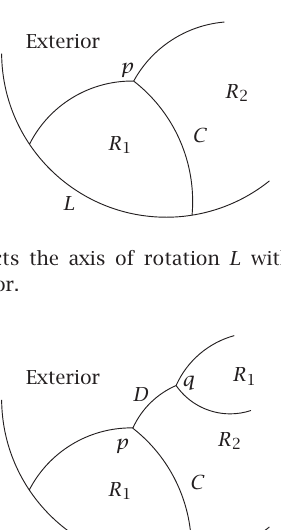
Figure 6.4 . The generating curve first branches at point p .